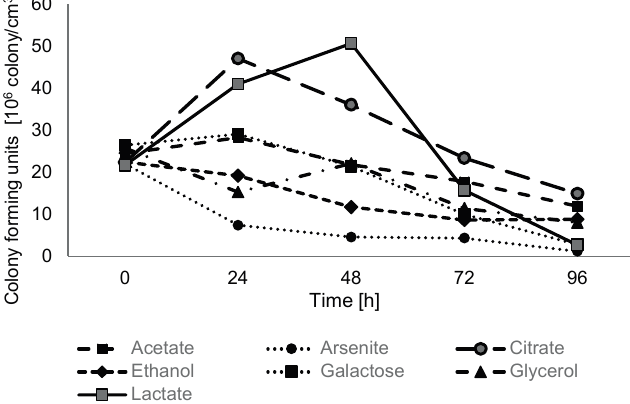
Figure 5. Anaerobic growth of Shewanella sp. O23S on minimal salt medium supplemented with sodium arsenate and various electron donors and carbon sources. The strain was grown on minimal salt medium with 2.5 mM sodium arsenate as an electron acceptor and 5 mM of one of the following electron donors: sodium acetate, sodium arsenite, sodium citrate, ethanol, galactose, glycerol, sodium lactate. SD <